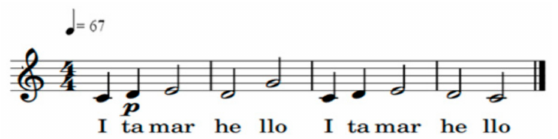
Figure 2. Notes of the “Hello